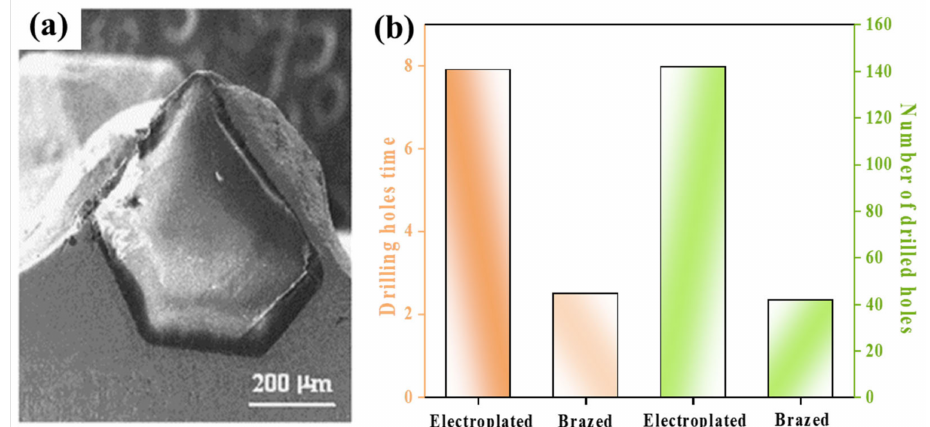
Figure 5. ( a ) SEM image of the cross-sectional of diamond grit; ( b ) Comparison of drilled time per hole and number of drilled holes between electroplated and brazed drill. Reprinted with permission from Ref. [25]. Copyright 2009, Elsevier.